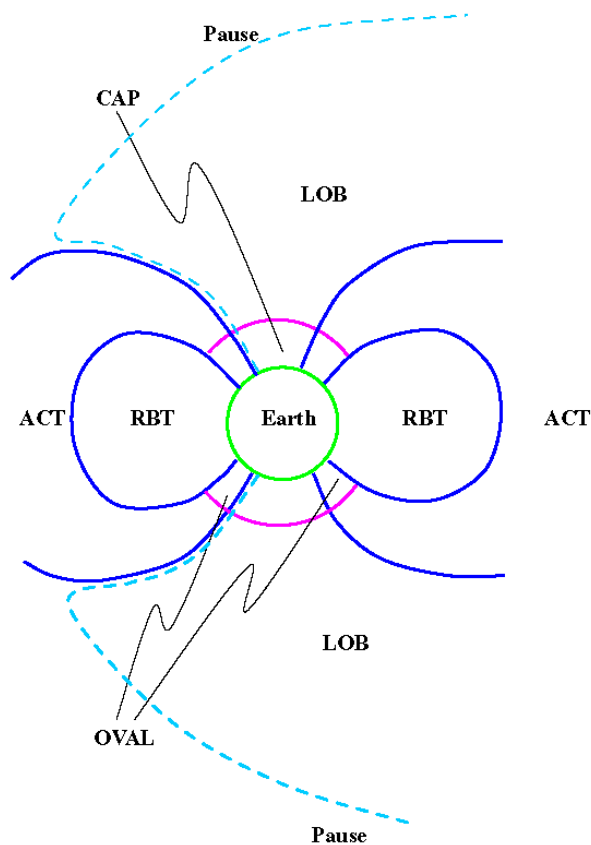
Fig. 8. Demonstration of regions in near-Earth magnetopause ex- plored by DSP. RBT means the radiation belt, ACT indicates the active regions including ring current, plasma sheet, magnetopause and cusp, and LOB marks the